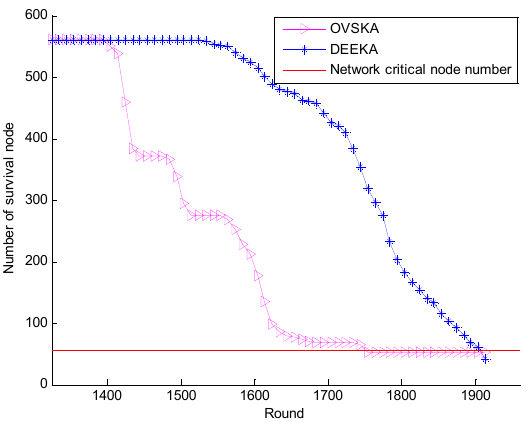
Figure 9. Number of survival nodes with the number of network running rounds.